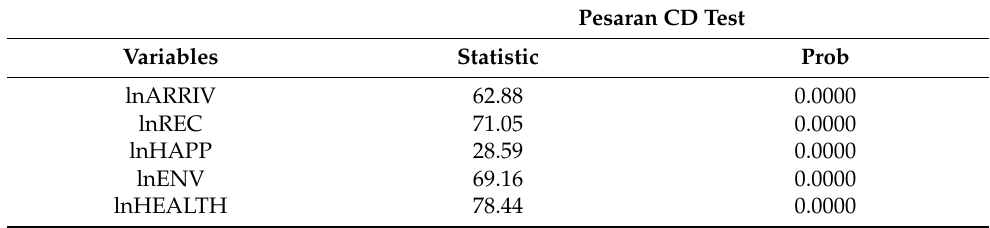
Table 3. Cross-sectional dependence